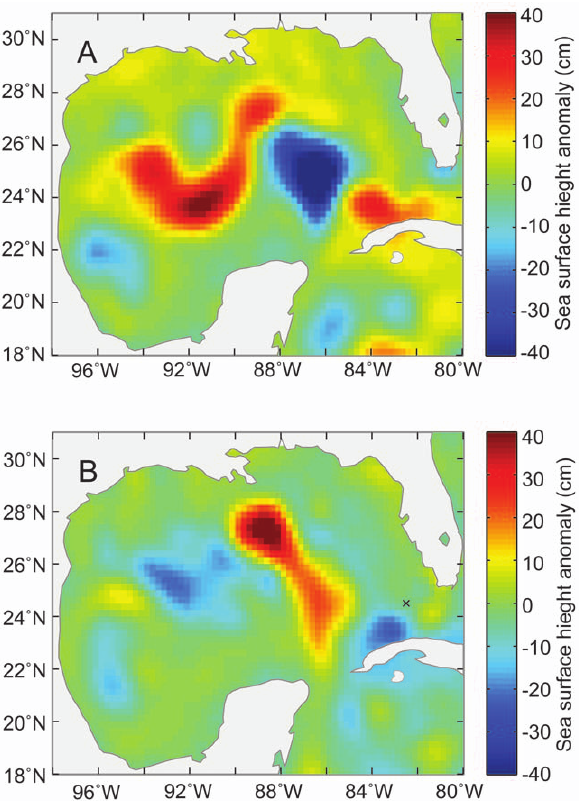
Figure 9. Expected probability of catching yellowfin tuna. Colors indicate the expected probability of catching one or more yellowfin tuna in the Gulf of Mexico on 15 May (A) 2002 and (B) 2005. Circles indicate actual relative yellowfin tuna CPUE for May 2002 and 2005. Crosses indicate locations where at least one longline set was deployed but no fish were caught.